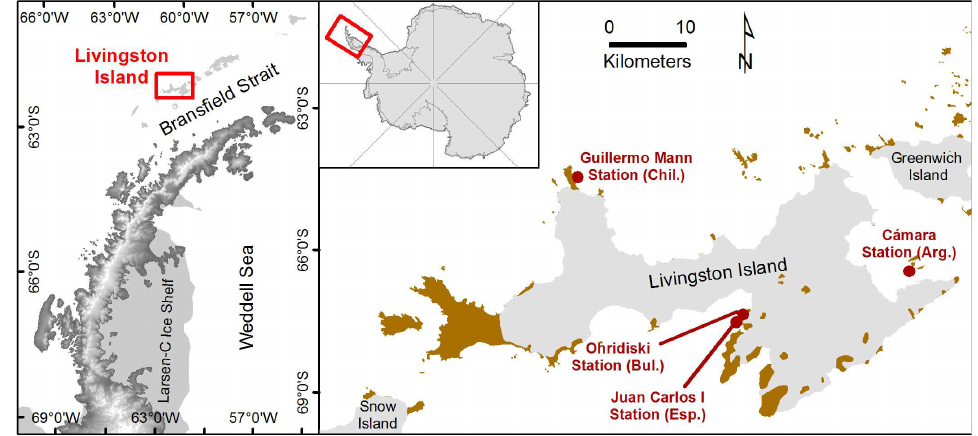
Figure 1. Location of Livingston Island, to the north-west of the tip of the Antarctic Peninsula. Brown denotes ice-free terrain, while grey is used for glacierized areas. Red dots mark the locations of research stations. Map base: SCAR Antarctic Digital Database, version 6.0; MOA coastline of Antarctica, NSIDC. Fig. 1. Location of Livingston Island, to the northwest of the tip of the Antarctic Peninsula. Green colour denotes ice-free areas, while grey is used for glaciated areas. Note that in subsequent figures only the glaciated area of the island is shown. Map base: SCAR Antarctic Digital Database, Vers. 6.0; MOA coastline of Antarctica, NSIDC.